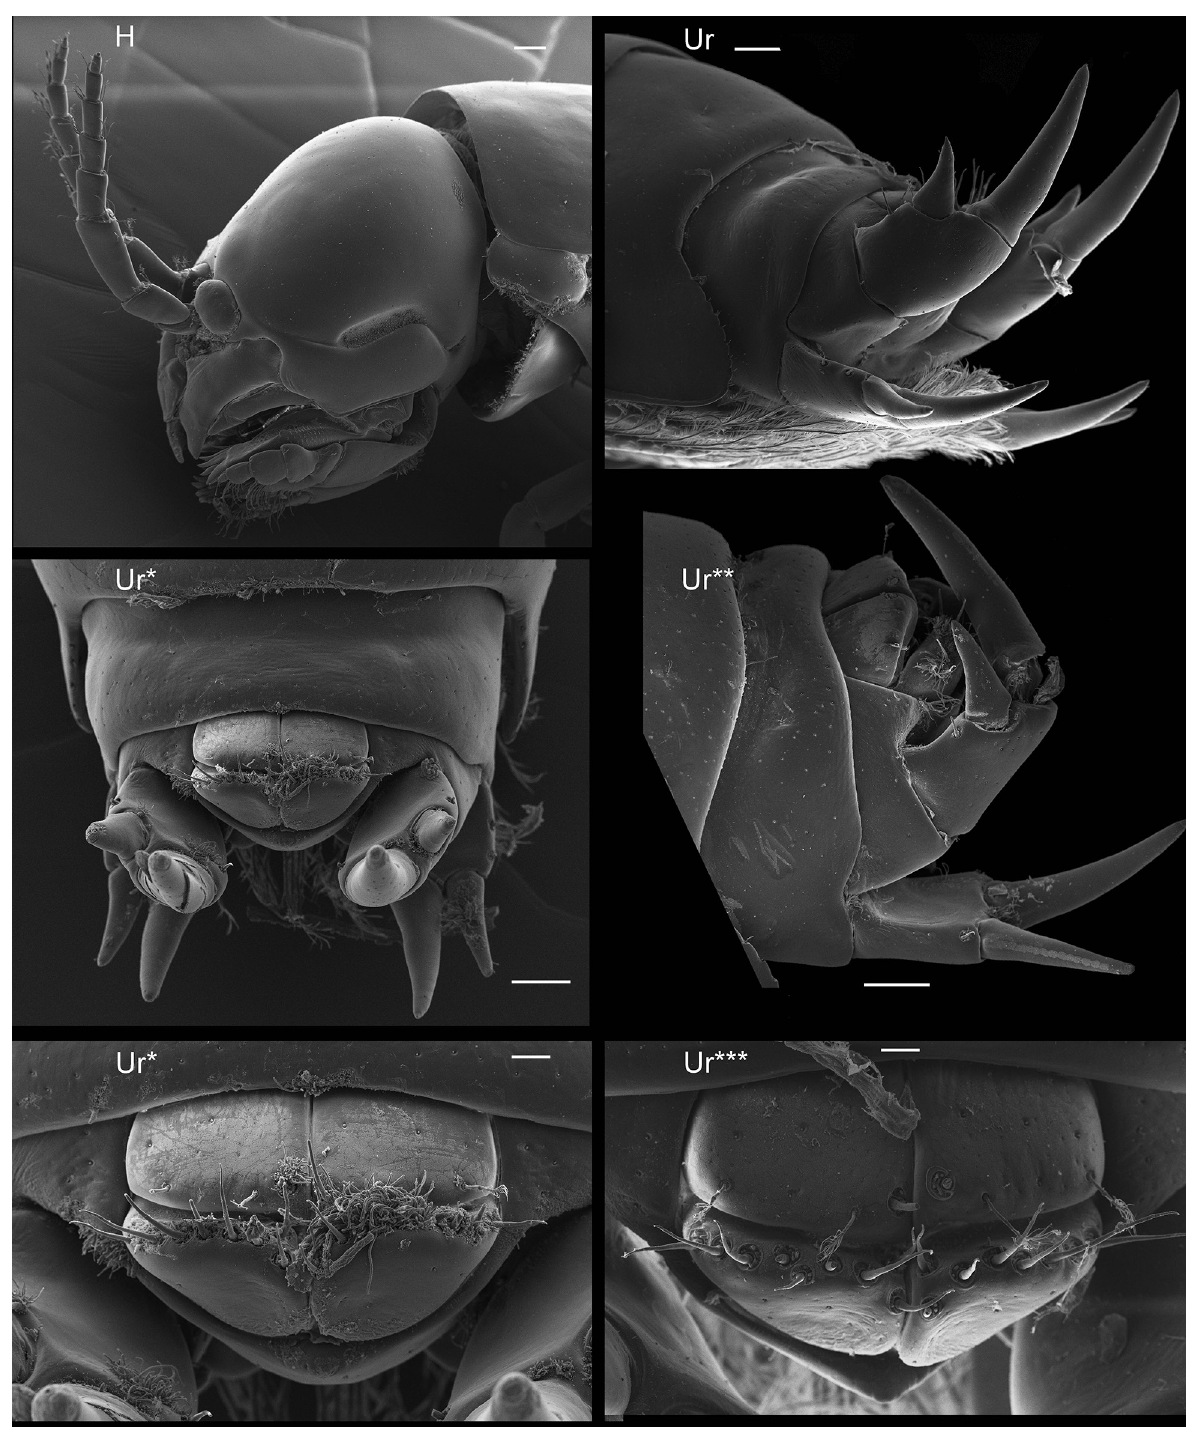
Figure 8. Bircenna thieli sp. nov. paratype SEM, gender indet, rego no. ZMH-K 45994 Bicheno, Tasmania, Australia. Scale bars: H, Ur, Ur* 100 µm; Ur*, 30 µm; ZMH-K 45995 Ur***, 20 µm.